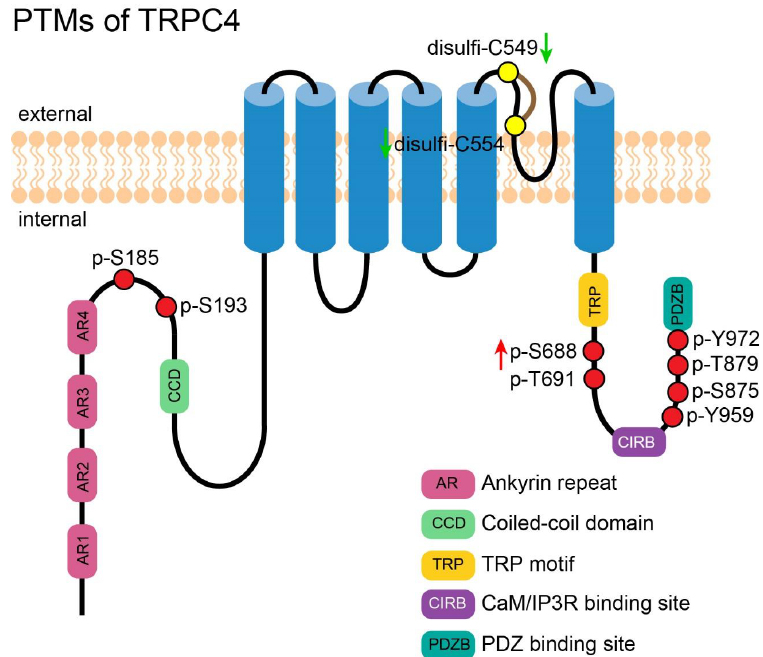
Figure 3. PTMs of TRPC4. A cartoon depicting TRPC4 with its important motifs and PTMs (those exact positions had been reported). PTMs are presented in circles. Red circles represent the reported phosphorylation sites of TRPC4, which are labeled in the format of a “p-amino acid-position”. Yellow circles represent the reported residues for disulfide bond formation, which are labeled in the format of a “disulfi-amino acid-position”. The green arrows near the labels denote the PTMs decreasing the channel’s activity. The red arrows near the labels denote the PTMs which increase the channel’s activity.